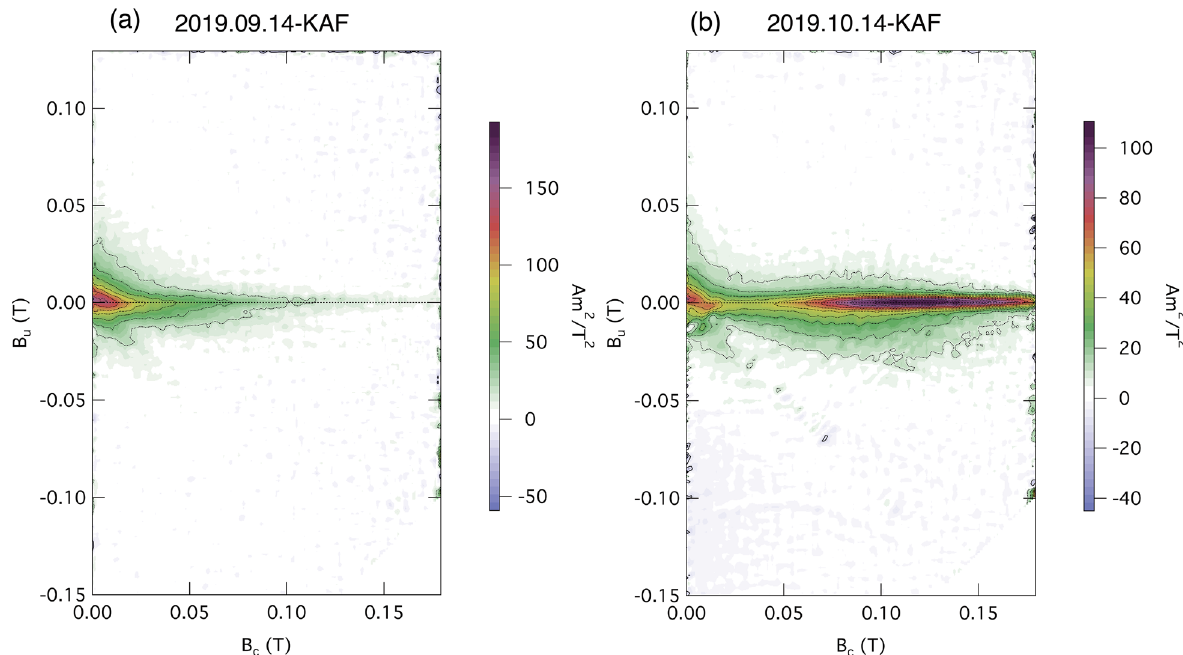
Fig. 3 Results of FORC measurement. a FORC diagram for the sample of September 14, 2019, collected from the KAF station. b FORC diagram for the sample of October 14, 2019, collected from the KAF station. Ash samples from October 14 indicate the presence of non-interacting SD grains with high coercivity and a narrow range of B u